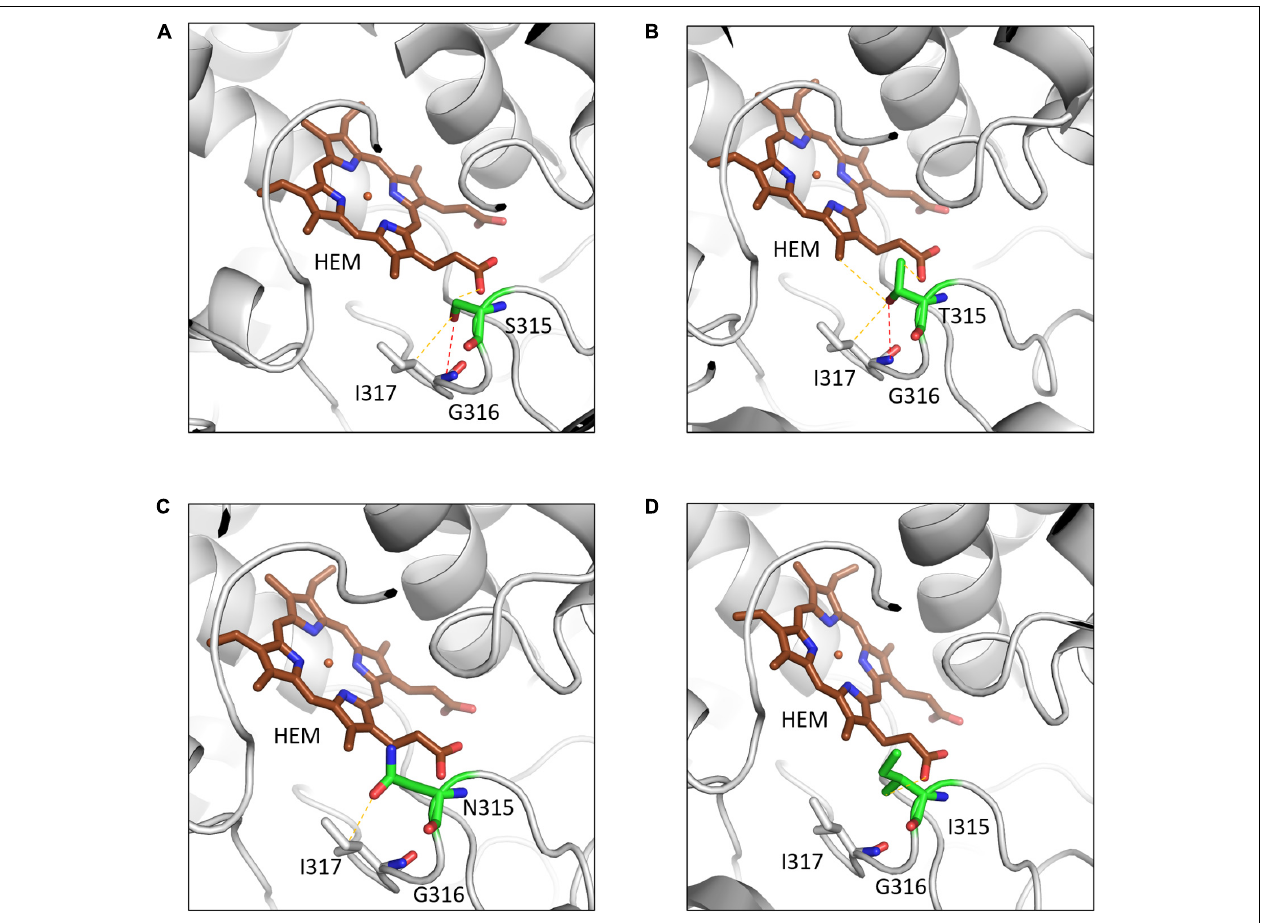
FIGURE 4 | The interatomic interactions in KatG formed by the wild-type residue S315 and the mutants S315T, S315N and S315I. (A) The wildtype residue S315 of KatG forms a hydrogen bond (shown as red dotted lines) with the main chain of I317 and a weak hydrogen bond (orange dotted lines) with haem (HEM) and sidechain of I317. (B) The mutant residue T315 gains an additional weak hydrogen bond and hydrophobic interactions with haem. (C) The mutant residue loses the hydrogen bond with I317 and a weak hydrogen bond with haem. (D) The hydrophobic sidechain of isoleucine retains the weak hydrogen bond with HEM and gains hydrophobic interaction with haem (Reproduced with permission from Munir et al.,